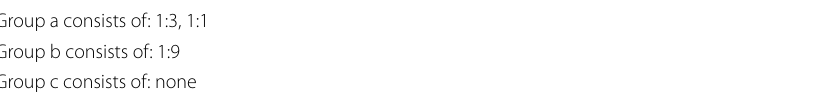
Table 25 HSD test groupings after ANOVA of AUC for the RUS factor